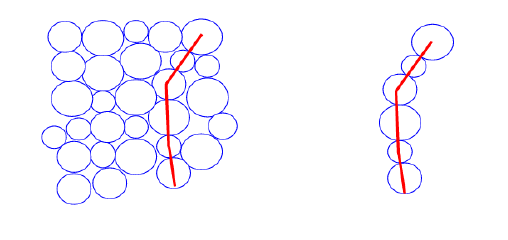
Figure 1. A granular or force chain from a network